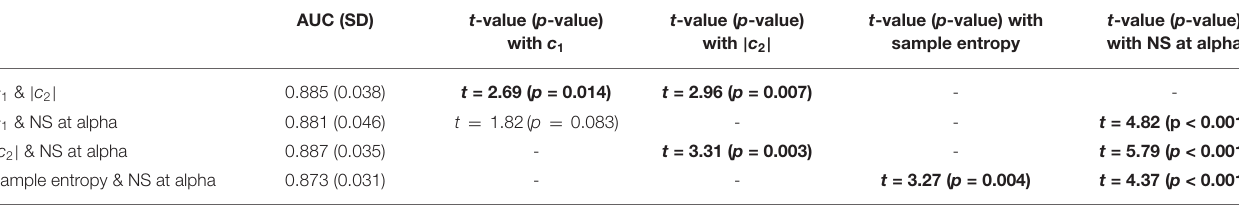
TABLE 6 | AUC for the combination of c 1 and | c 2 | and the combination of the NS at alpha, c 1 , | c 2 | and sample entropy.